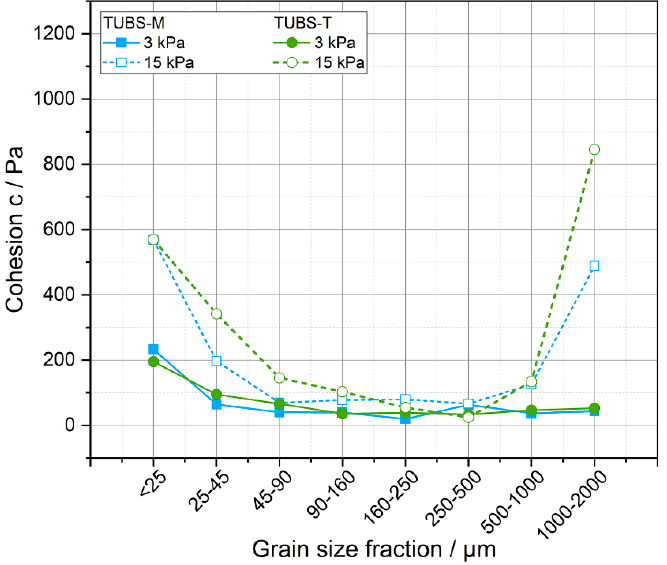
Figure 10. Cohesion values of the grain size fractions of TUBS-M and TUBS-T at shear stresses of 3 and 15 kPa.